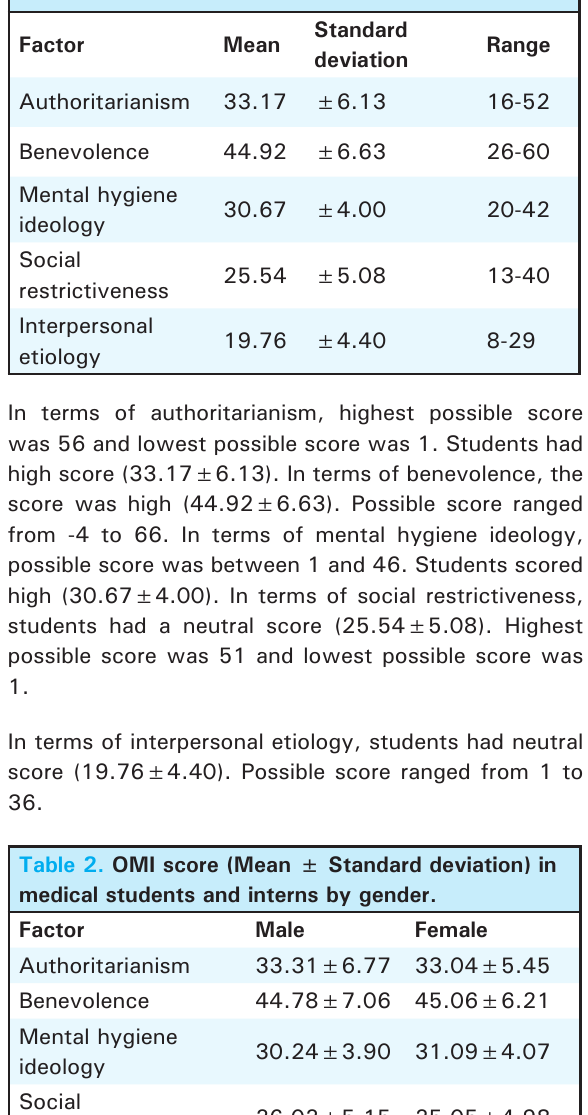
Table 1. OMI score in medical students and interns.